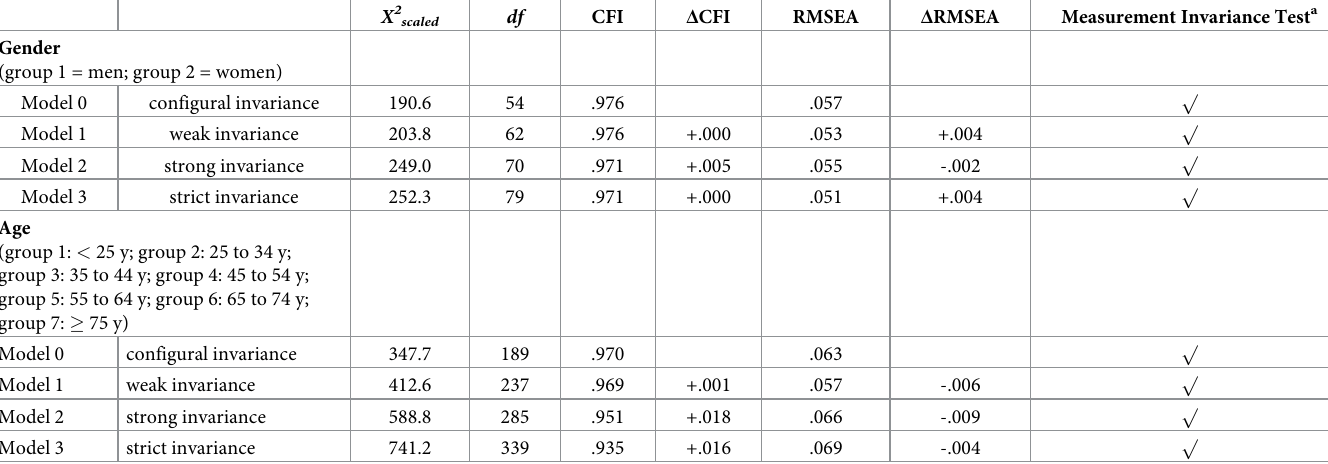
Table 4. Analysis of factorial invariance for age and gender using multigroup confirmatory factor